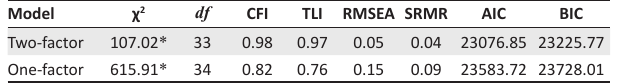
TABLE 1: Results of the measurement models.